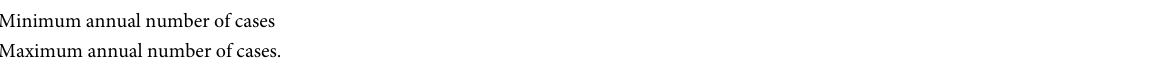
Linear regression